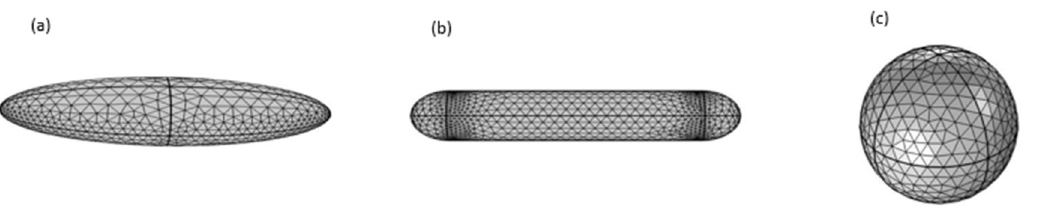
Figure 4. Different shapes used in simulations: ( a ) nano-ellipsoid, ( b ) nanorod and ( c ) nano- sphere.